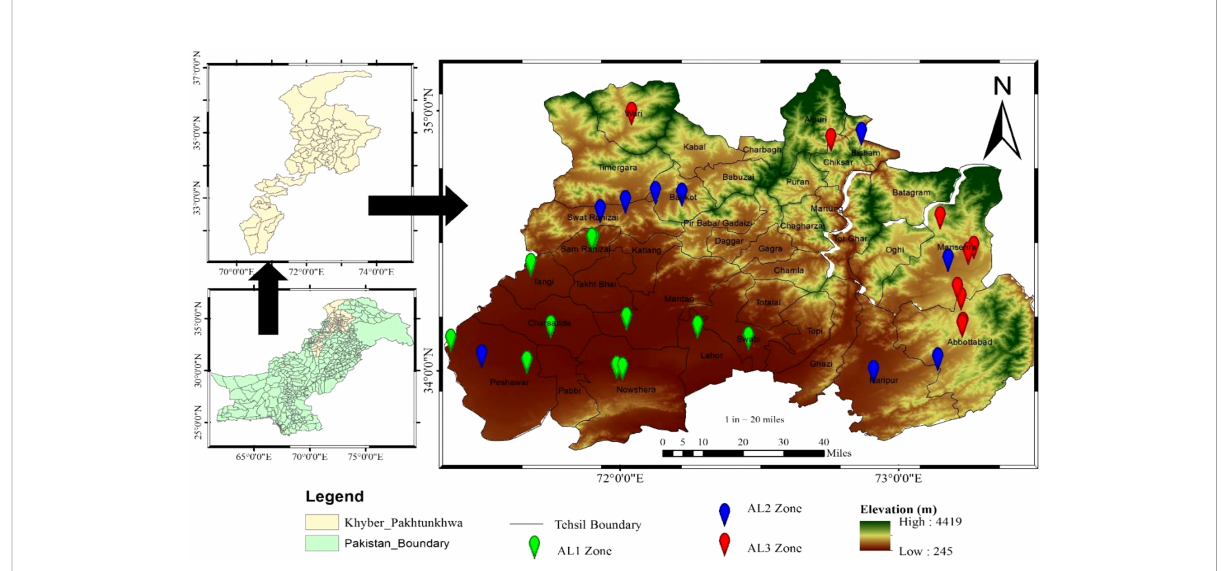
FIGURE 1 Study area map showing distribution of the studied plant along different